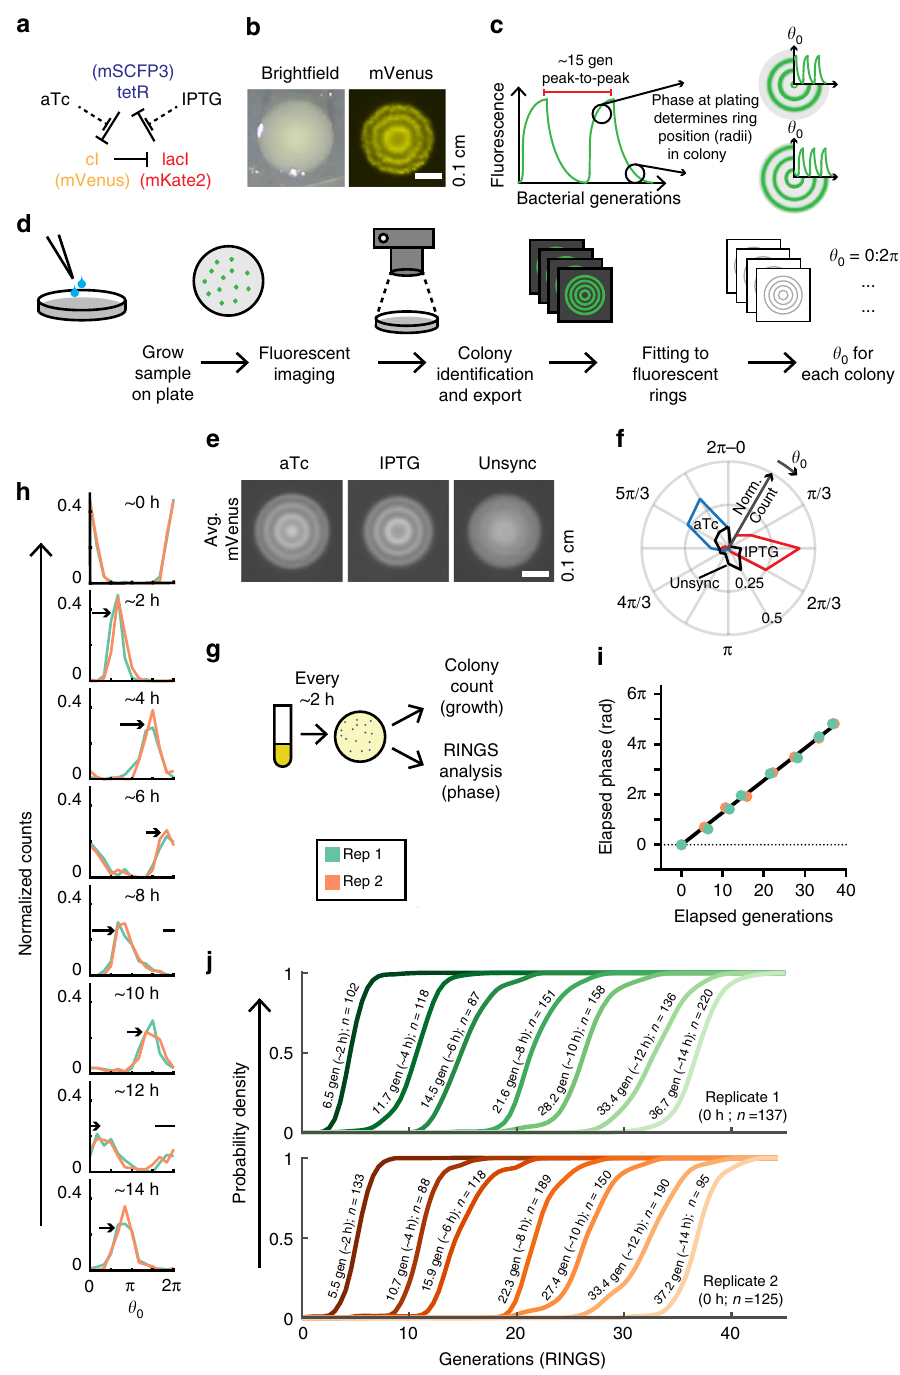
RINGS quanti fi es growth changes within the mouse gut . IPTG- synchronized E. coli PAS715 bacteria were delivered by oral gavage to mice that had been treated with a single dose of streptomycin 24-h prior (Fig. 4a; replicate: Supplementary Fig. 5a). Streptomycin-treated mice have been extensively utilized as a model for E. coli and S . Typhimurium growth in the mouse gut, which is not a native or permissive host for human-derived E. coli strains 33, 34 . We have previously shown that delivery of E. coli to mice that were treated with single doses of streptomycin